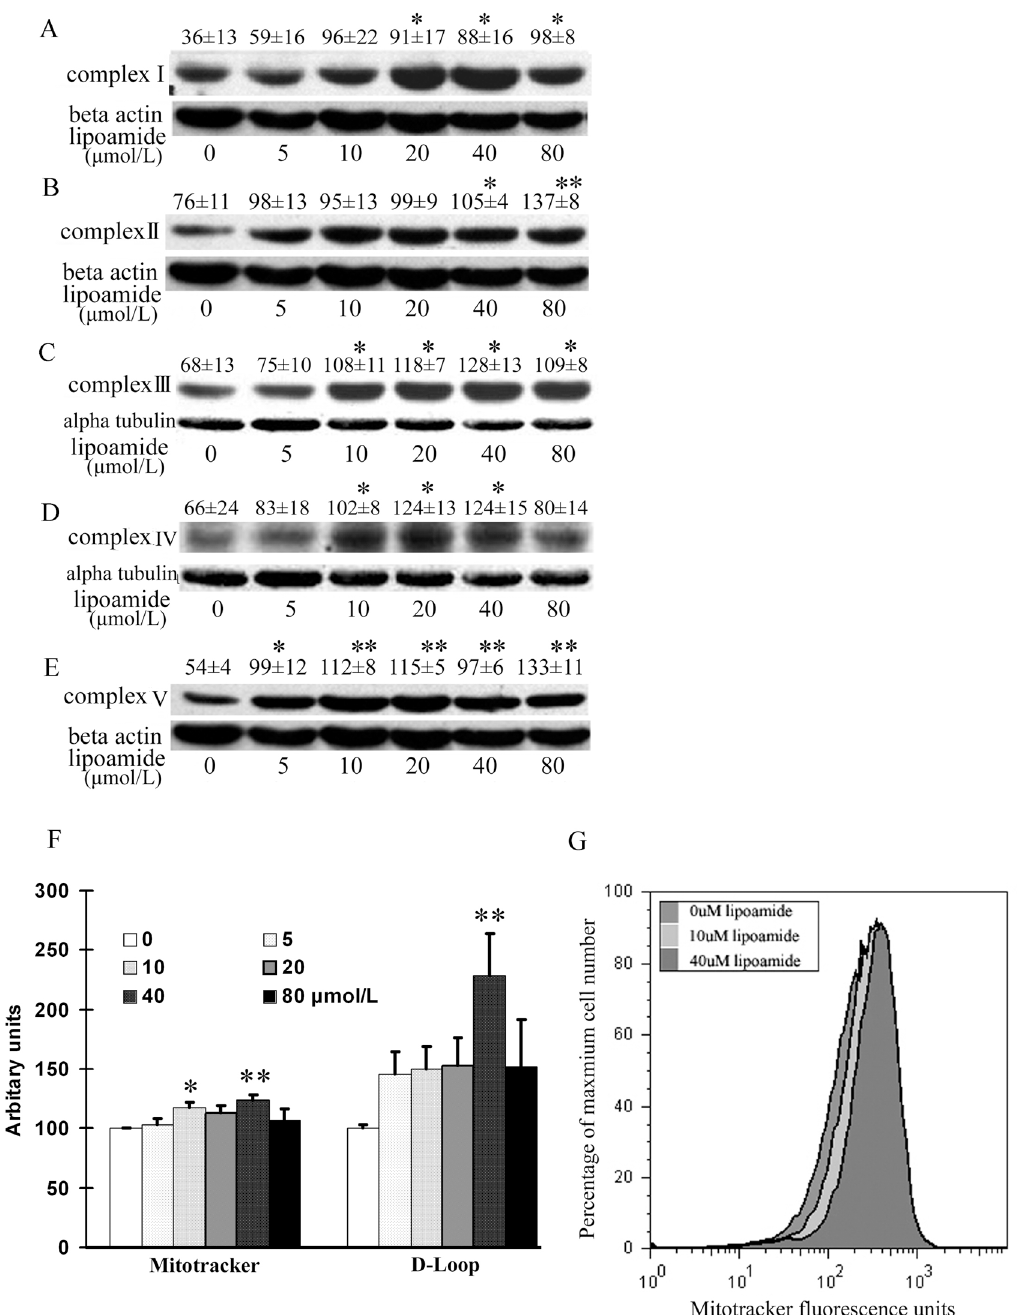
Fig 1. LM increased ETC complex I, II, III, IV and V protein expression (A-E), mitochondrial DNA copy number (F) and viable mitochondria (G). ARPE-19 cells were treated with the indicated concentrations of LM for 48 h, and then subunits expression of the complexes were detected by western blot. The subunits tested were 39 KD, 70 KD, 51.6 KD, 57 KD and 56.6 KD for complexes I to V (A to E), respectively. The images are representative; the quantitative results are from optical density analysis of images of three independent experiments. For complexes I, II and V, the loading control was β -actin; for complexes III and IV, it was α -tubulin instead. Results are the ratios of the complex densities to those of β -actin or α -tubulin. Values are means ± SEM. Differences were evaluated statistically with student ’ s t test. * p < 0.05, and ** p < 0.01 vs. untreated control (0 μ mol/L). (F) LM increased viable mitochondria and mitochondrial DNA copy numbers. ARPE-19 cells were treated with the indicated concentrations of LM for 48 h. For viable mitochondria measurement, cells were stained with Mitotracker Green. Fluorescence values read by flow cytometry were considered as estimates of viable mitochondria. Results are in arbitrary units normalized by setting the fluorescence of untreated (0 μ mol/L LM) cells to 100. Values are means ± SEM from three independent experiments, each performed on three samples at each concentration. For mitochondrial DNA copy number measurement, real-time PCR was employed for assaying the